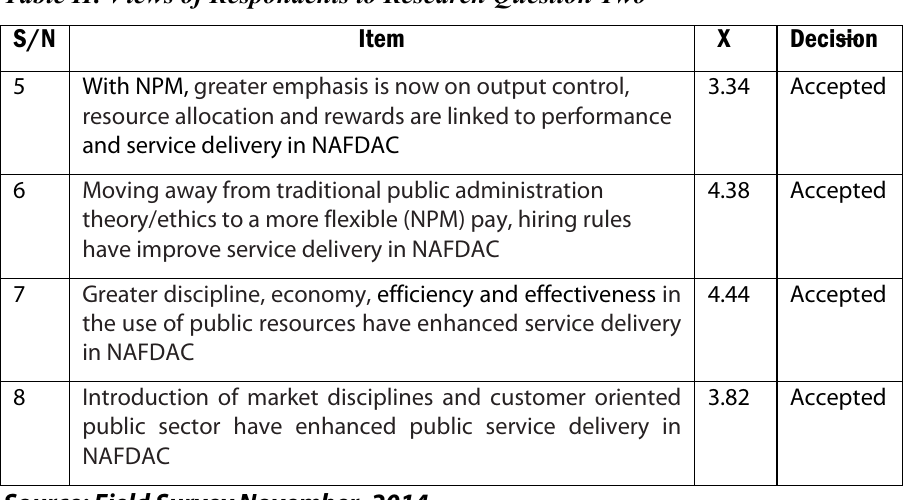
Table II: Views of Respondents to Research Question